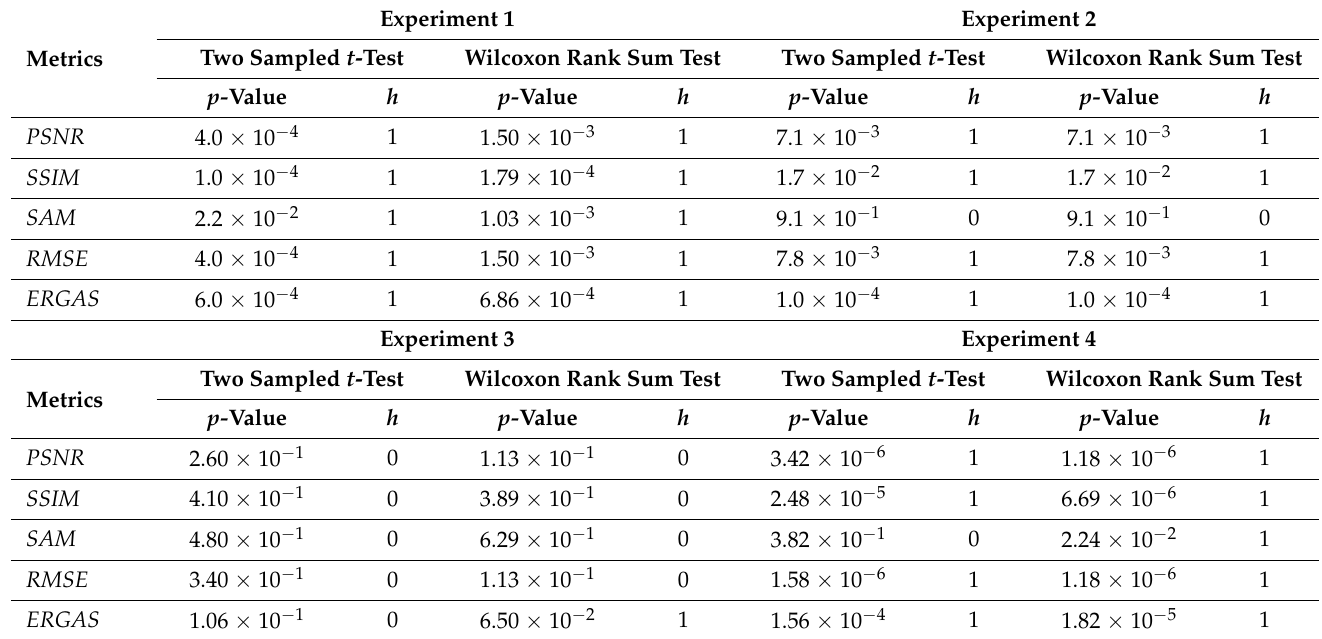
Table 6. Statistical tests between UMSEh (best overall) and GAN (best competing model) for all experiments, where h = 1 indicates the difference is significant at the 95% significance interval. Experiment 1 is for the 4 × resolution